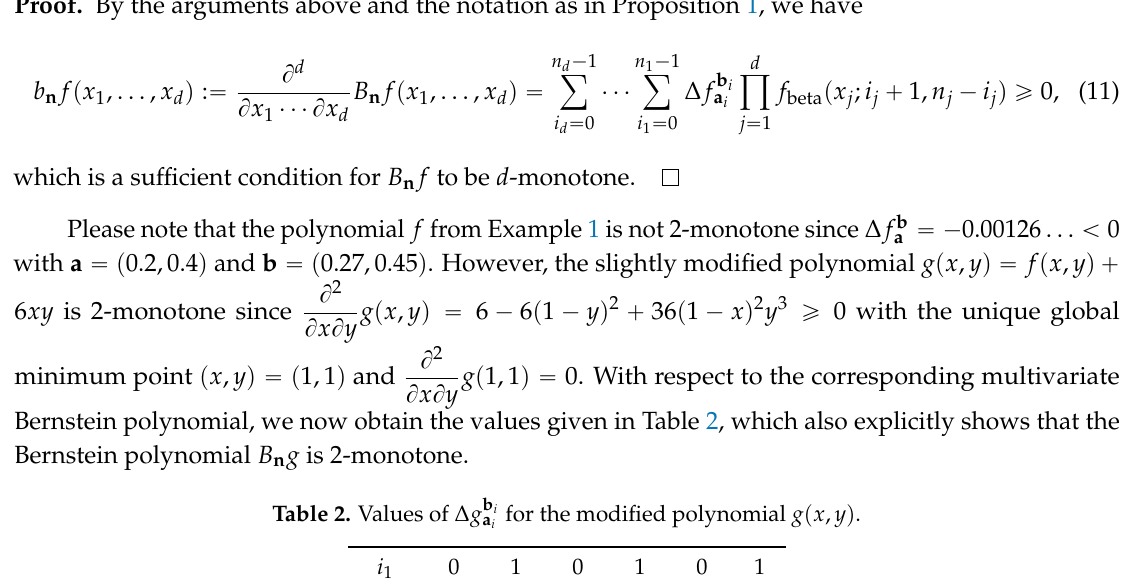
Table 2. Values of ∆ g b i a